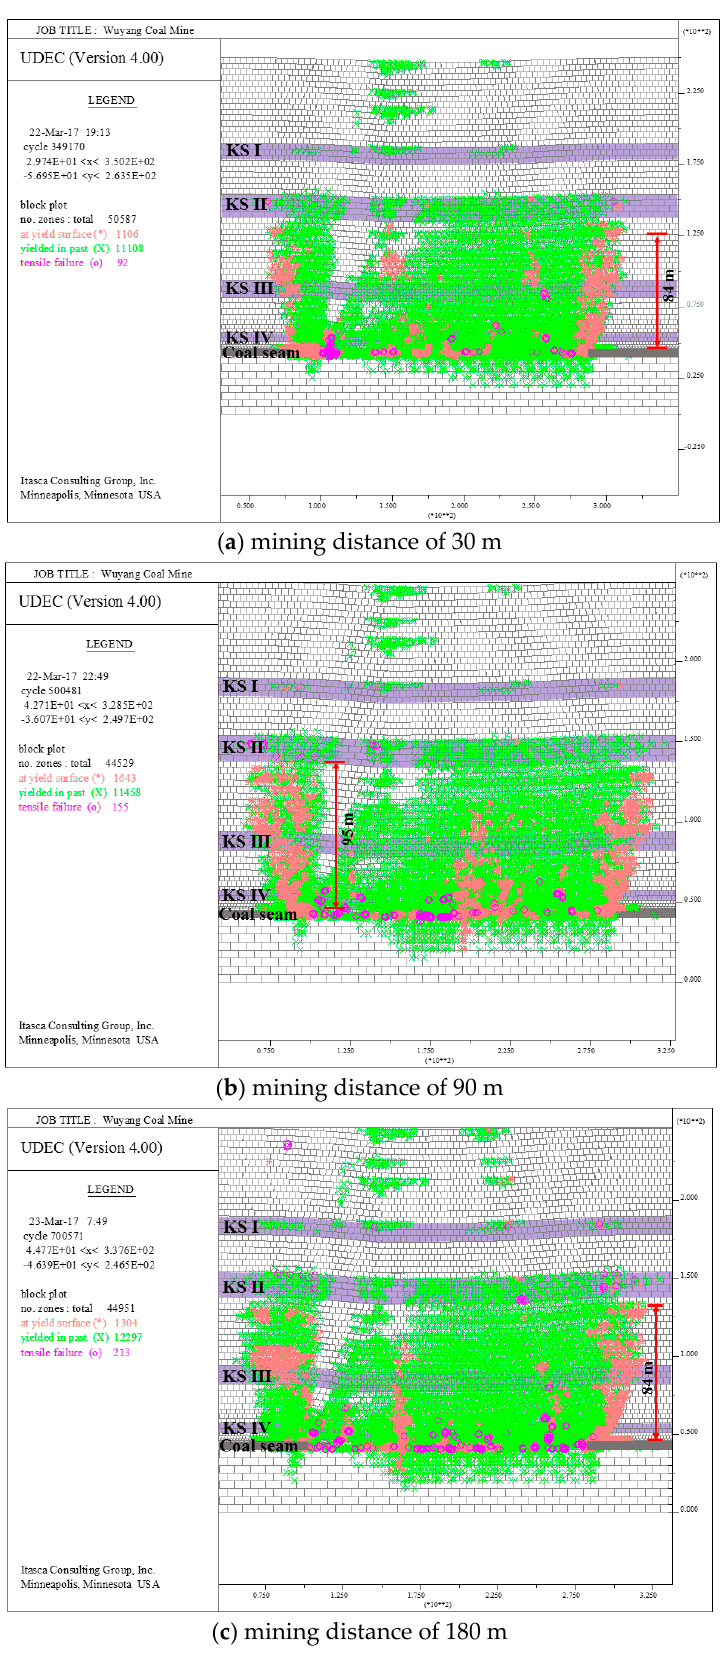
Figure 5. Development patterns of FWCZ in the overburden when the lower coal seam is mined.